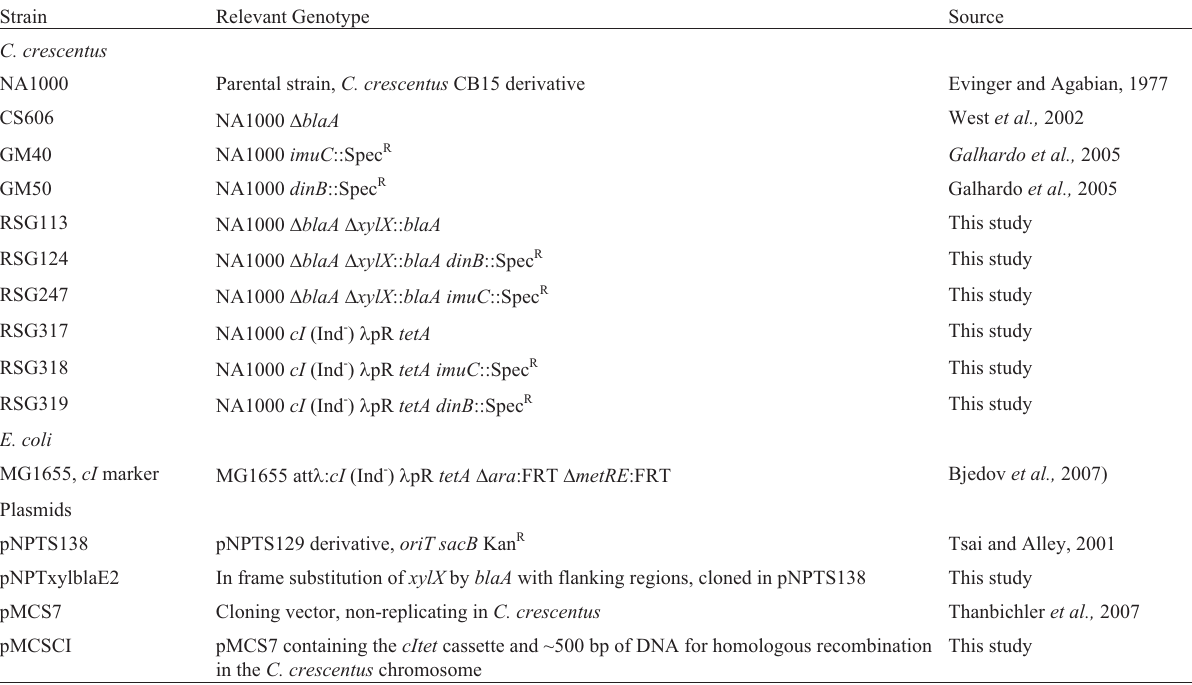
Table 1 - Bacterial strains and plasmids used in this